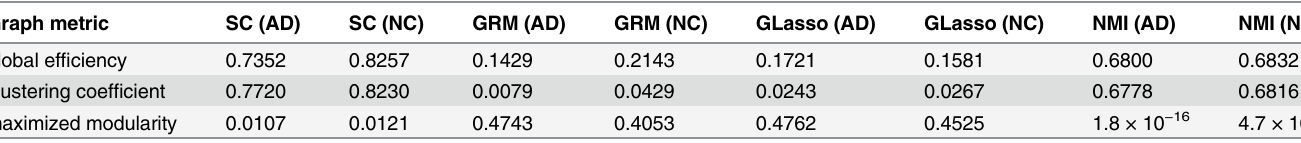
Table 4. Measurements of the weighted graphs obtained by different